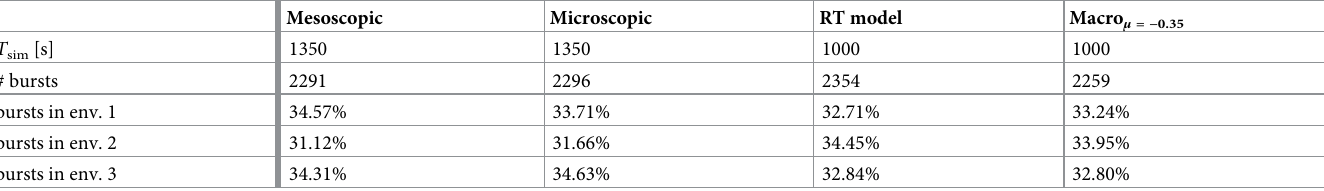
Table 3. Simulation results complementing Fig 6. Mesoscopic